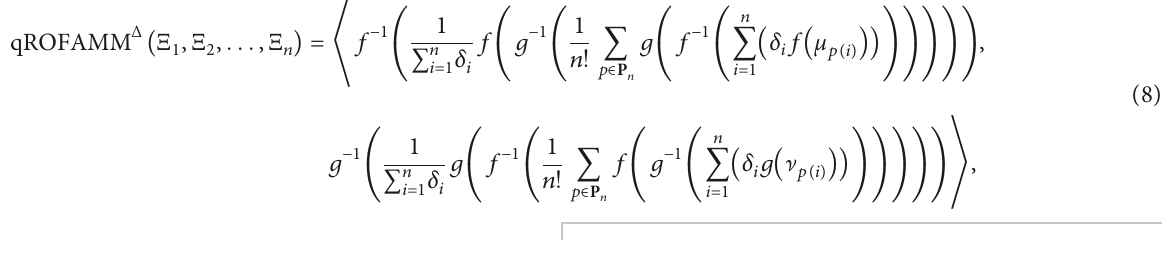
Archimedean generalized geometric averaging